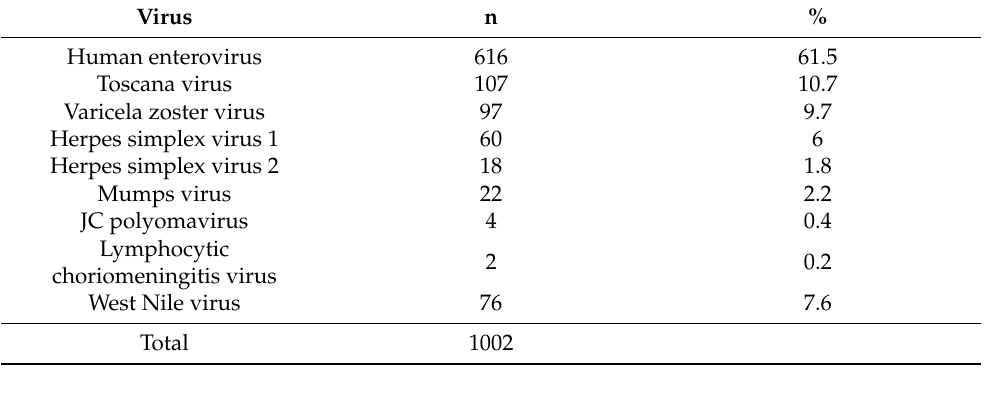
Table 3. Etiology of VME cases, 1988–2020.